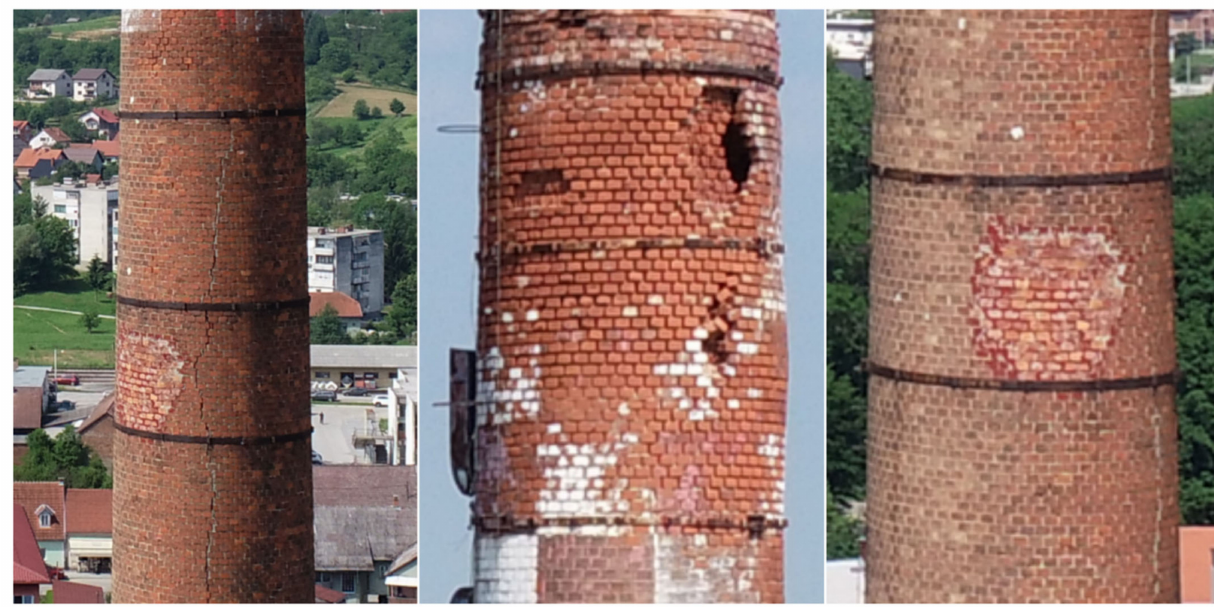
Figure 2. Current condition and structural damage of the studied industrial masonry chimney of the former Duga Resa Cotton Industry in Duga Resa,